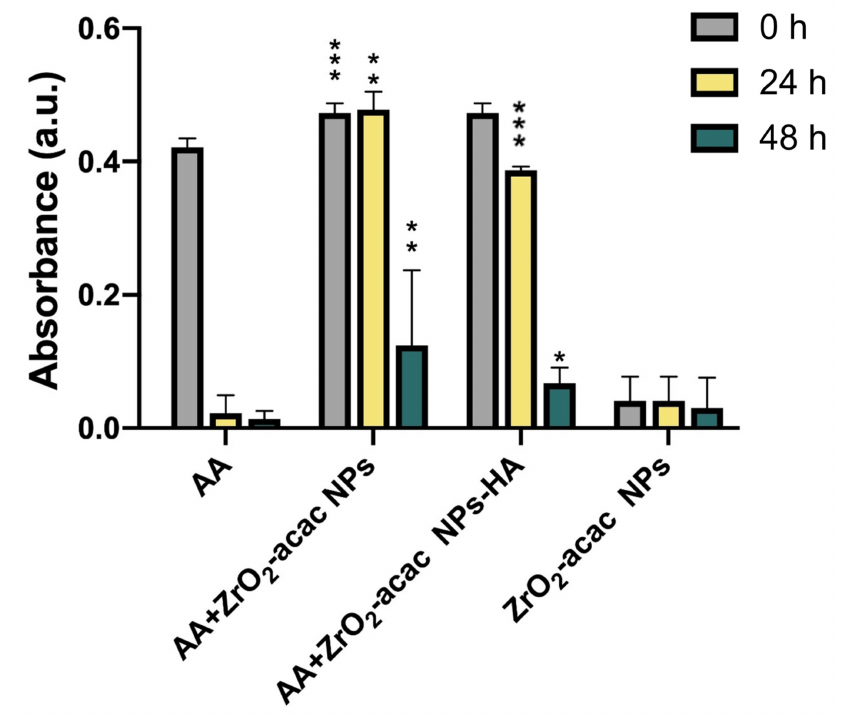
Figure 4. Acellular in vitro AA assay for evaluating the oxidative potential of bare and functionalized NPs at a concentration of 0.1 mg mL − 1 after 0, 24, and 48 h. Results are expressed as the mean ± s.d. ( n ≥ 3). The level of significance was set at probabilities of * p < 0.05, ** p < 0.01, and *** p < 0.001. Non-significant data are not